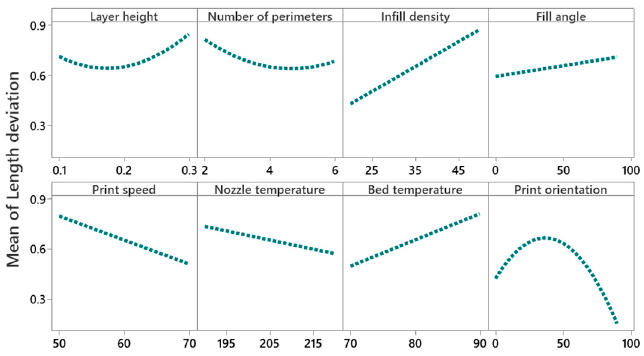
Figure 6. Main effect plot for length deviation.